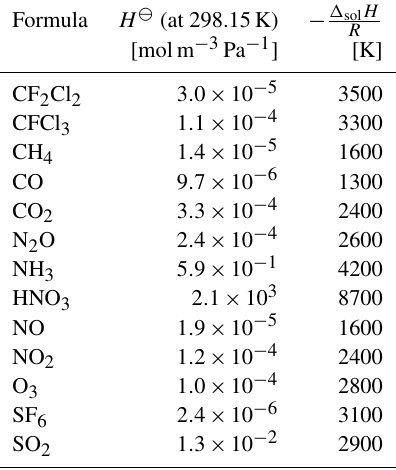
Table 1. Henry’s law constants for water as a solvent. See Sander (2015) for